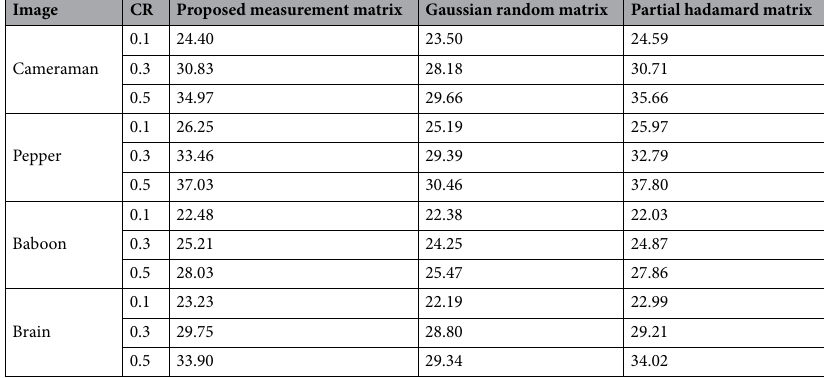
Figure 5. Decrypted Cameraman image with incorrect keys: ( a ) decrypted image with x 01 ( b ) decrypted image with y 01 10 − 15 ; ( e ) decrypted image with y 02 x 02 +